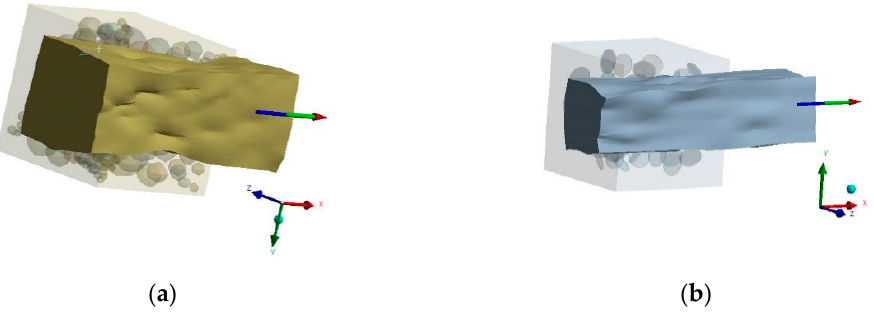
Figure 7. The deformation state of the finite element micromechanical model of composite materials randomly reinforced with spherical ( a ) and short cylindrical inclusions ( b ) with applied boundary conditions with undeformed model.